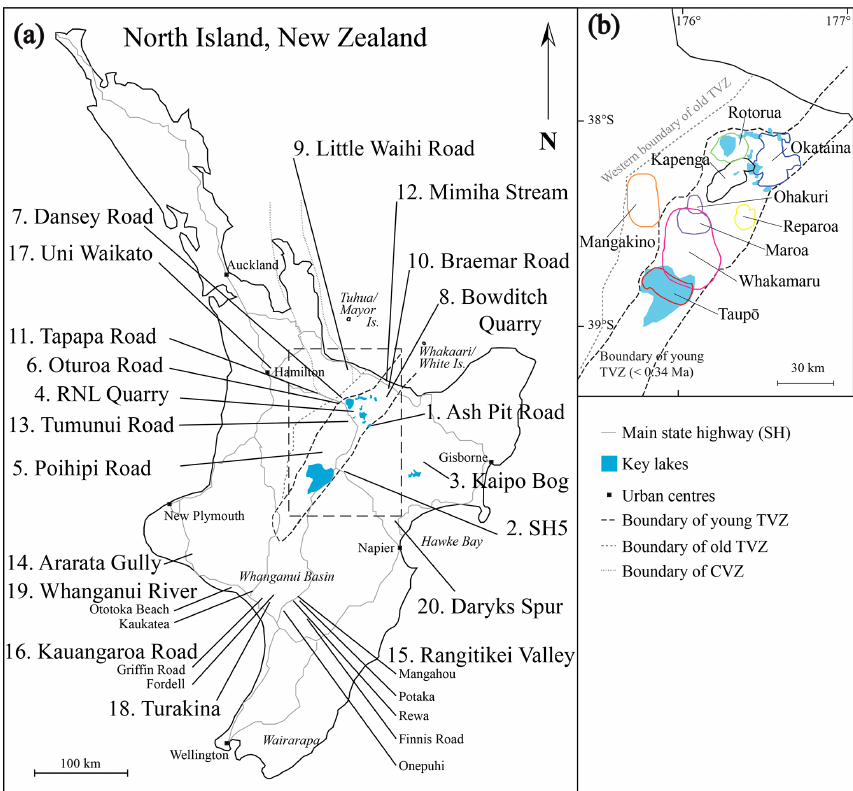
Figure 1. (a) Map of the North Island, New Zealand, detailing the samples sites where the reference tephra deposits for the TephraNZ database were collected. Outlines of CVZ (Coromandel Volcanic Zone) and TVZ (Taup¯o Volcanic Zone) are shown by dashed lines. Exact co-ordinates for all sample sites are detailed in Table 1. (b) Inset, outline shown in (a) , the calderas of TVZ (details from Houghton et